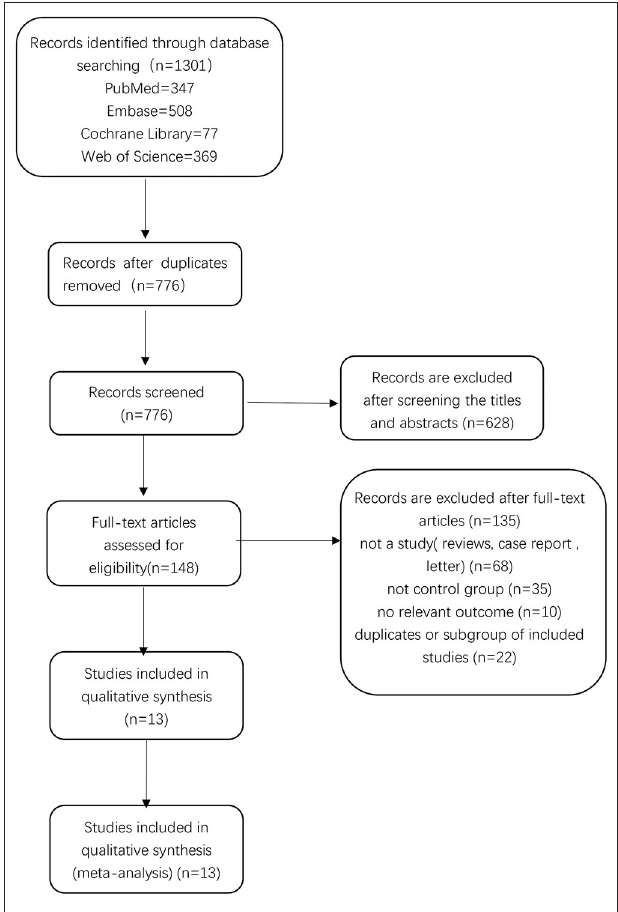
FIGURE 1 | Flow chart of the study selection